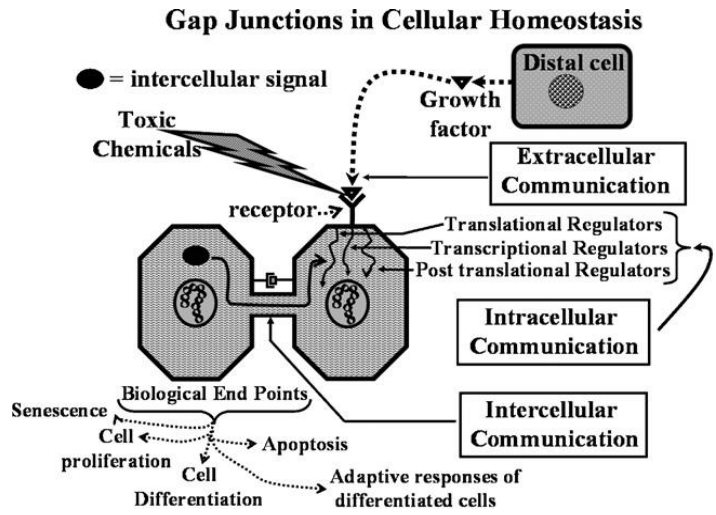
Figure 1. Gap junctions in cellular homeostasis. Extracellular signals, such as growth factors, cytokines, hormones, toxicants, extra-cellular matrices, and cell adhesion molecules, that vary for each cell type (adult stem cell, progenitor, and terminally differentiated), interact with receptor-dependent or receptor-independent targets, which then activate intracellular signal transduction pathways that induce the transcription of genes through activated transcription factors. These specific intracellular pathways operate under cascading systems that cross-communicate with each other in controlling the expression of genes that direct the proliferation, differentiation, and apoptosis of cells within a tissue. These multiple intracellular signaling check points are further modulated by intercellular signals traversing gap junctions, thereby maintaining the homeostatic state of a tissue. Abnormal interruption of these integrated signaling pathways by food-related and environmental toxins/toxicants will disrupt the normal homeostatic control of cell behavior (Permission granted from Toxicology 2010, 270, 18–34